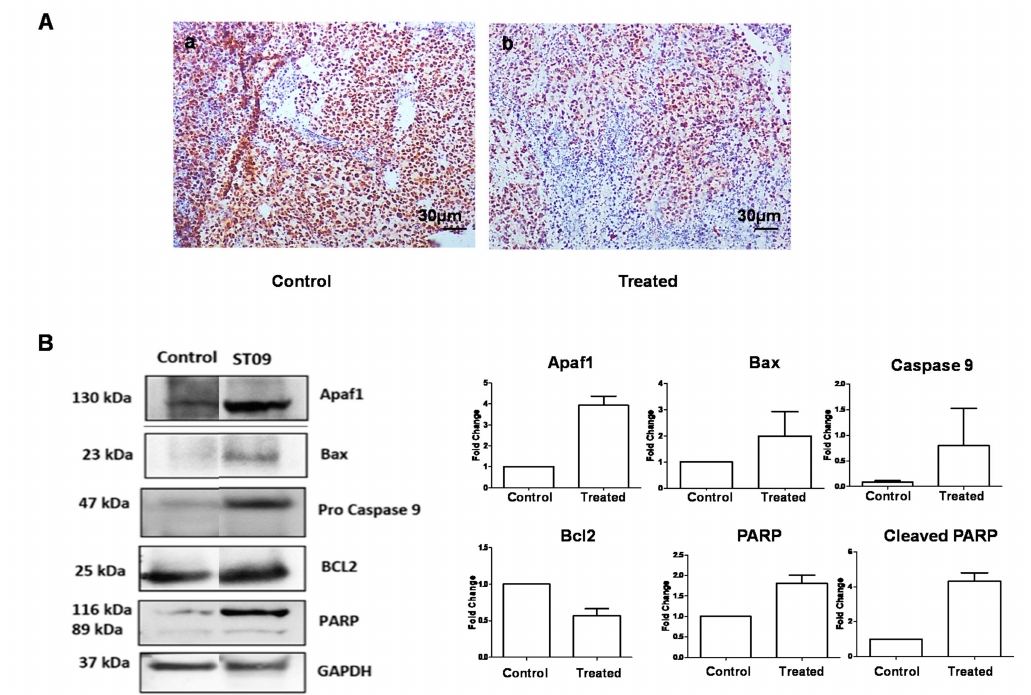
Figure 9. Immunohistochemistry and Western blot analysis post ST09 treatment in vivo. ( A ) PCNA stained control tumor(a) and treated tumor(b). ( B , C ) Western blot and quantification of pro and anti-apoptotic protein markers. A one-sample t-test and one-way ANOVA test was performed, and the p -value was calculated between control and ST09 treated